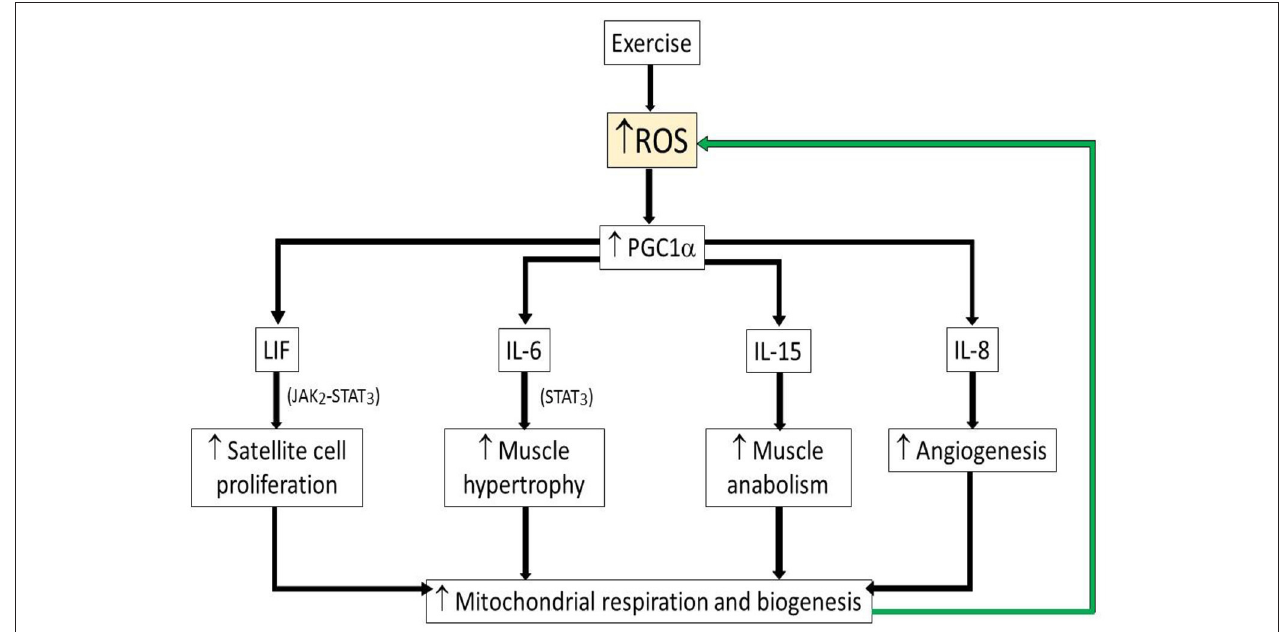
FIGURE 3 | Schematic illustrating beneficial role of ROS during exercise. Upwards arrow indicates increased levels of parameter. Green arrow indicates positive feedback activation. ROS, reactive oxygen species; PGC1 α , peroxisome proliferator-activated receptor gamma coactivator 1-alpha; LIF, leukemia inhibitory factor; LI-6, interleukin-6; LI-15, interleukin-15; IL-8, interleukin-8.